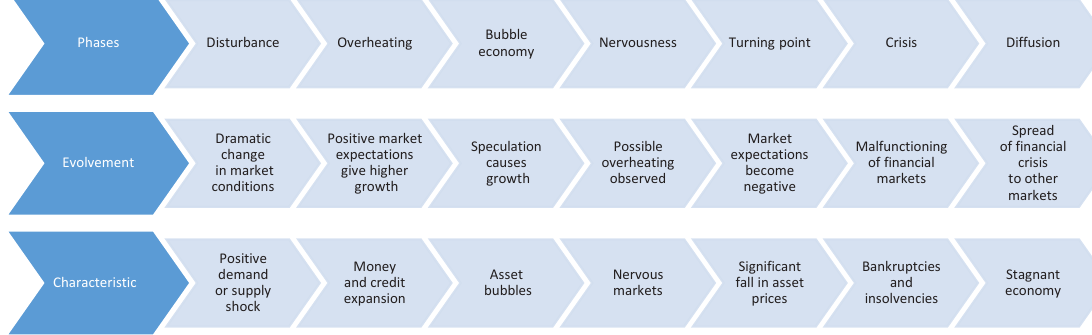
Figure 2. Seven-stage dynamic financial crisis